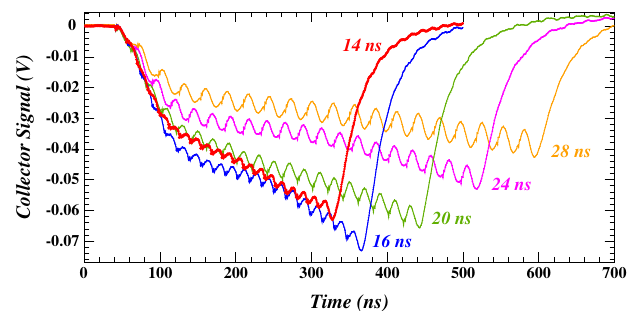
FIG. 3. Electron detector signals recorded for 10- and 20-bunch trains of 5.3 GeV positrons for an average bunch population of 1 . 3 × 10 11 . The enhanced signal during the first 10 bunches of a 20-bunch train relative to that for the 10-bunch train shows that electrons were trapped during the entire 2 . 3 μ s interval prior to the return of the bunch train.